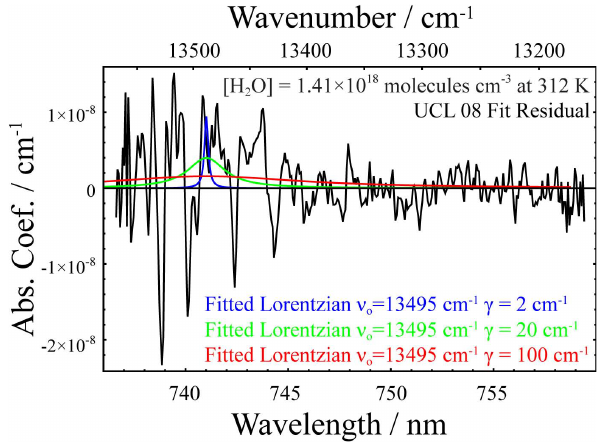
Fig. 7. The BBCRDS residual spectrum from Fig. 6 Panel 3B (black) shown here over the full bandwidth of the BBCRDS mea- surement. The residual spectrum is fitted with Lorentzian functions of various half widths ( γ =2, 20 and 100cm − 1 ; blue, green and red respectively) centred at the water dimer band frequency predicted by Low and Kjaergaard